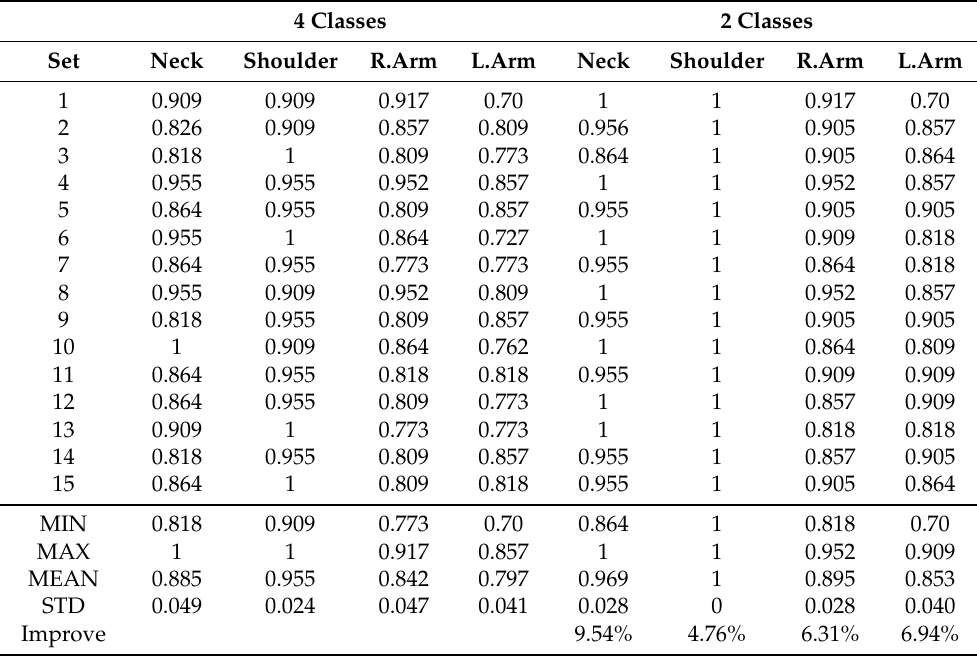
Table 6. Bootstrap re-sampling evaluation with 15 random